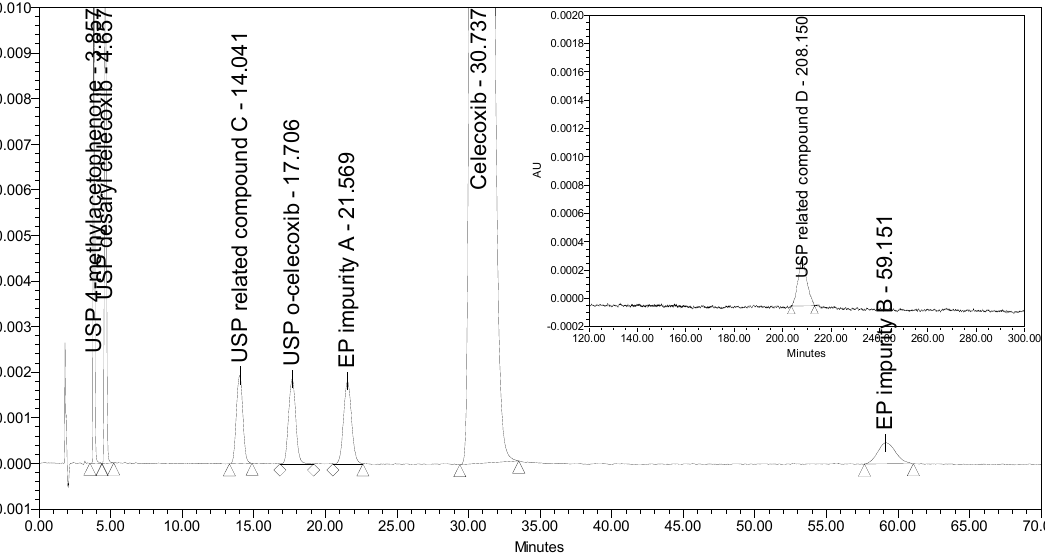
Figure 4. A chromatogram of celecoxib at a concentration of 0.5 mg/mL spiked with six investigated impurities at the 0.5% level (presented from 0 to 70 min) and with USP related compound D at the 2.0% level (presented from 120 to 300 min) obtained using the method by Rao et al.